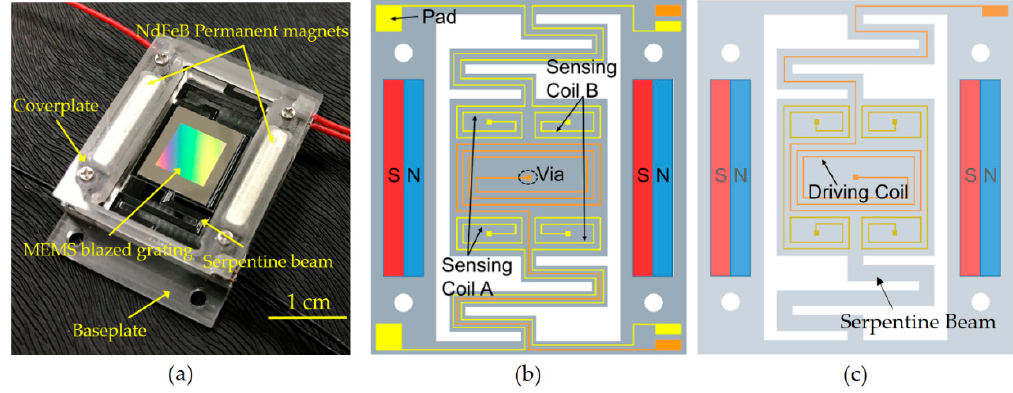
Figure 1. ( a ) Photograph of the flame-retardant 4 (FR4)-based electromagnetic scanning micrograting. ( b ) Top layer and ( c ) bottom layer layouts of the FR4 platform integrated with a driving coil and differential angle sensing coils. The coils at the top and bottom layers are connected with vias. The motion of the scanning micrograting can be approximated as a forced oscillating system.